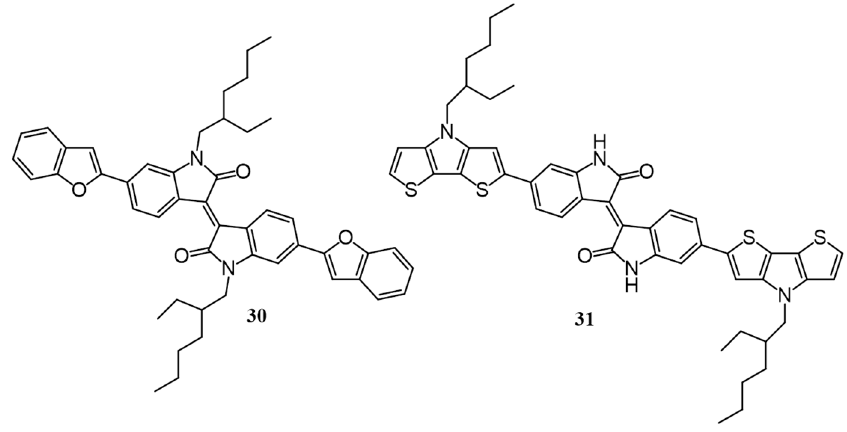
Figure 12. Chemical structure of 30 and 31 synthesized by Roncali et al. [59].